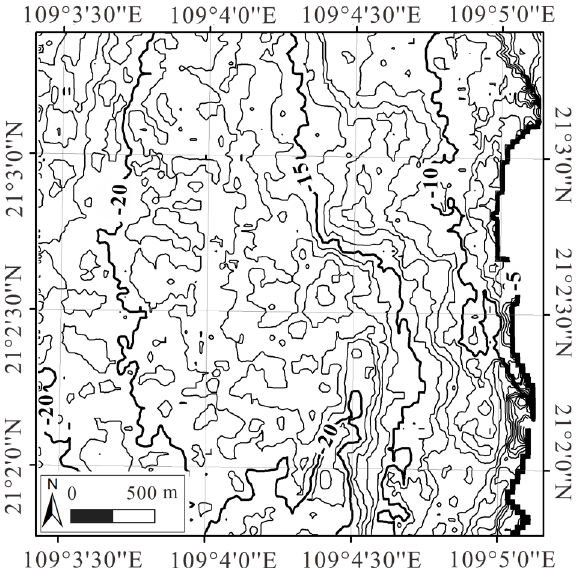
Figure 7. The results of water depth retrieved using the proposed model.